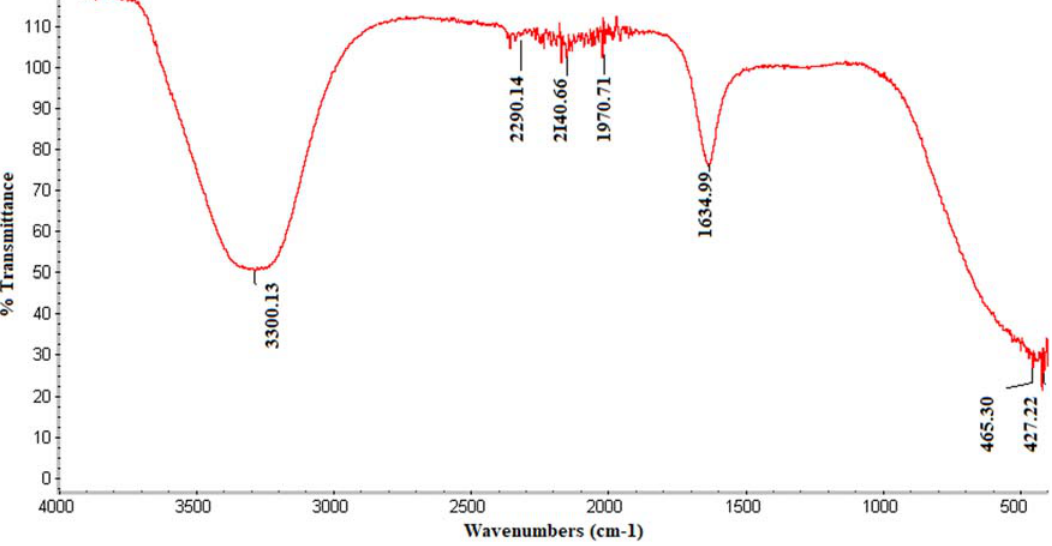
Figure 2: IR spectra of the biosynthesized AgNPs prepared with aqueous R. o ffi cinalis leaf